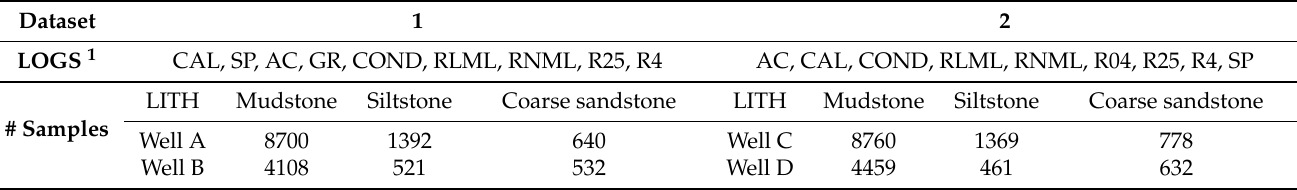
Table 1. Datasets